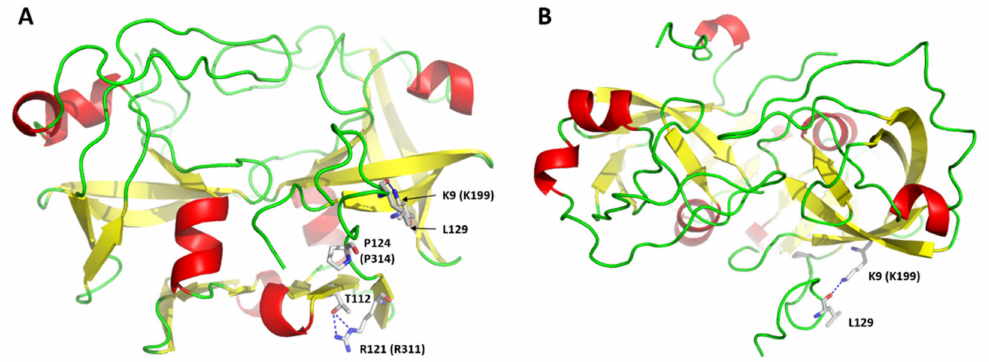
Figure 12. Missense alterations of ASPRV1. Homology model of SASP14 is represented in front ( A ) and top views ( B ). The residues shown by sticks are labeled according to SASP14 numbering, but for the K199E, R311P, and P314T variants [8] the SASP37 numbering is also shown in parentheses. Putative H-bonds are shown by blue dotted